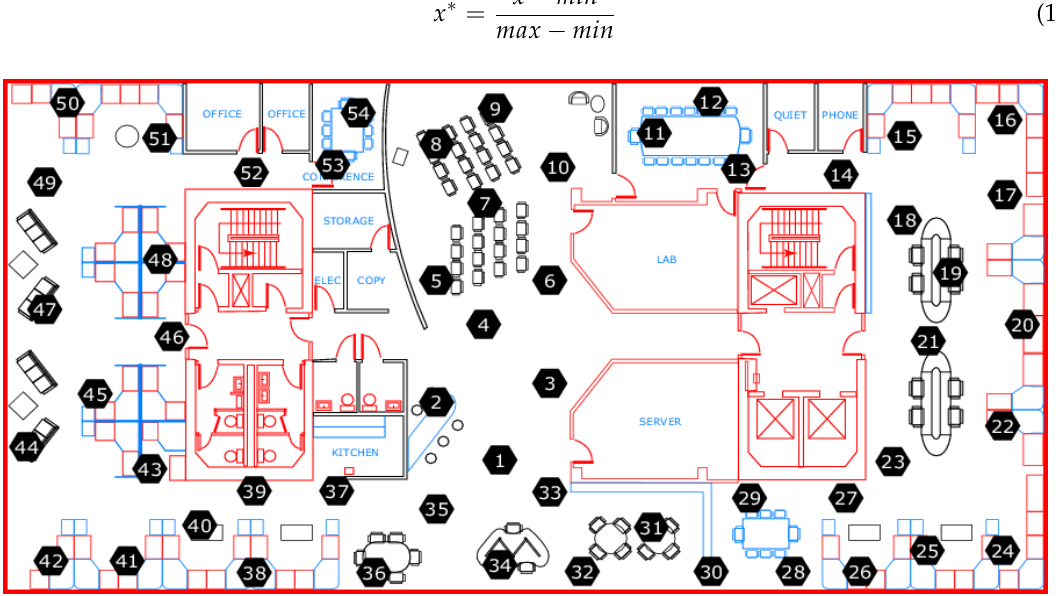
Figure 4. Sensor node distribution in Intel Lab.